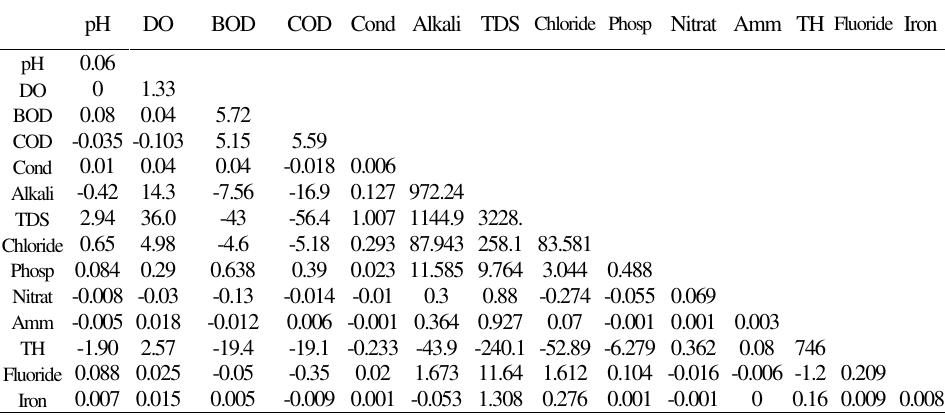
Table 9. Similarity matrix